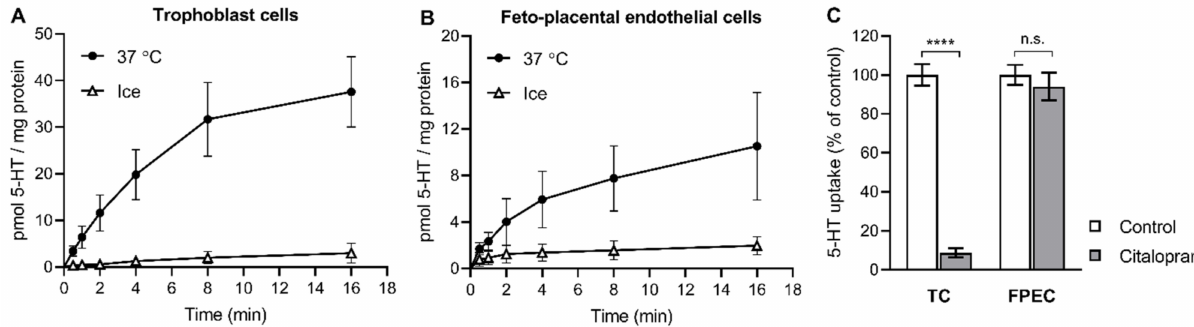
Figure 1. ( A , B ) Time- and temperature-dependent uptake of 5-HT into primary placental cells. Human primary ( A ) tro- phoblasts and ( B ) feto-placental endothelial cells were incubated in the presence of radiolabeled 5-HT (10 − 7 M) at 37 ◦ C or on ice for 0.5 to 16 min. Values are the means ± SEM from two donors, each analyzed in triplicate. ( C ) The effect of citalopram on the uptake of 5-HT into primary placental cells. Trophoblast cells (TC) and feto-placental endothelial cells (FPEC) were incubated for 10 min in the presence of radiolabeled 5-HT (10 − 7 M) and citalopram (10 − 7 M) or vehicle (control). The specific uptake was calculated as the difference between transport at 37 ◦ C and on ice and expressed as a percentage of the control. Values are the means ± SEM of two independent experiments, each performed in two or three replicates. **** p < 0.0001 compared to vehicle, n.s. not significant (Sidak’s multiple comparisons test following two-way